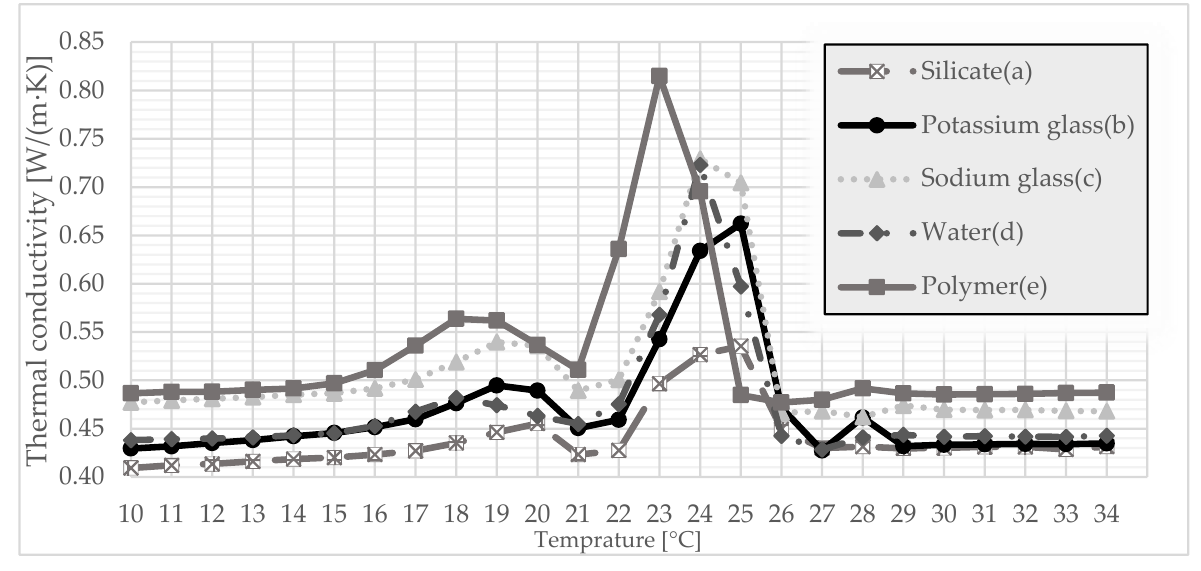
Figure 6. Coefficient of thermal conductivity for a granulate coated with: (a) silicate; (b) potassium glass; (c) sodium glass; (d) water; and (e) a polymer.